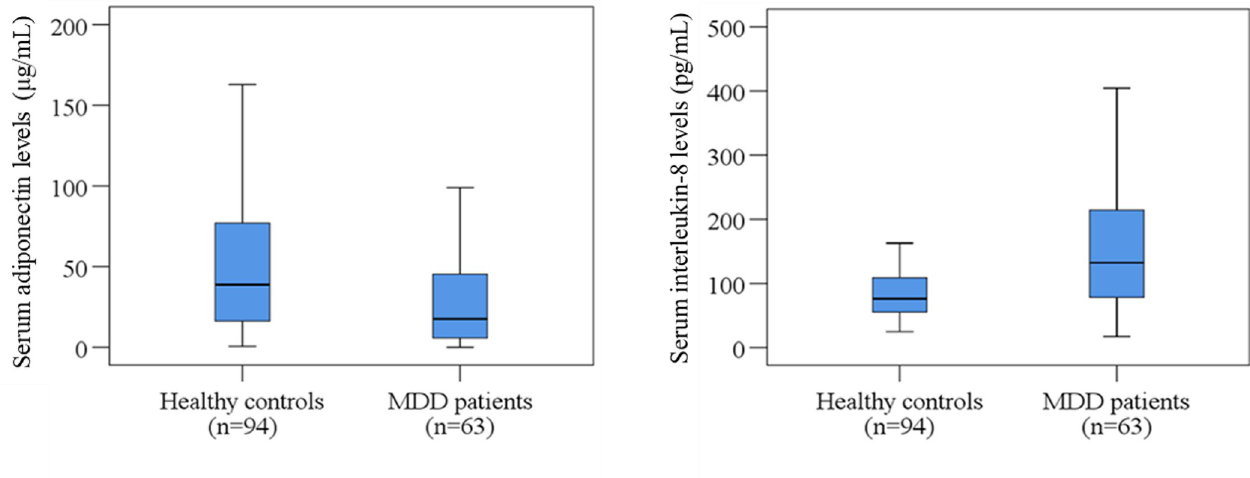
Fig 1. Changes of serum adiponectin and interleukin-8 levels in MDD patients and healthy controls. Boxplot graphs showing the median, maximum and minimum value